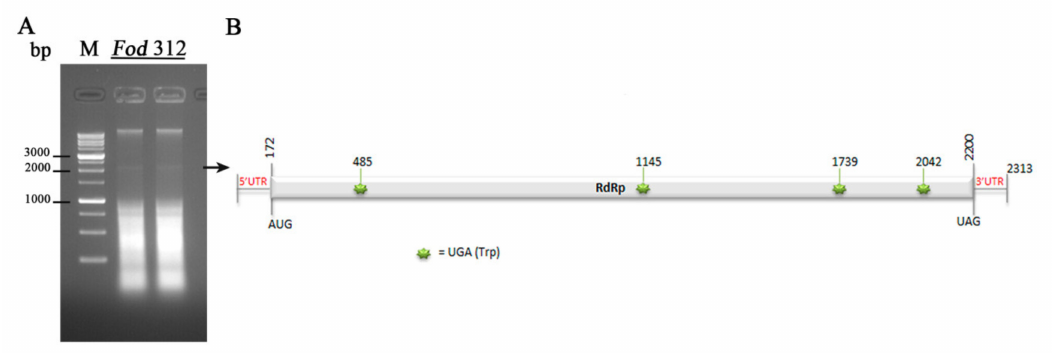
Figure 2. Detection of a mitovirus in isolate Fod 312 and schematic representation of its genomic organization. ( A ) Agarose gel electrophoresis of the dsRNA-enriched extract obtained by cellulose column chromatography from isolate Fod 312 of Fusarium oxysporum f. sp. dianthi. Lane M: 1 kb molecular weight marker (Nippon Genetics, Japan). ( B ) Schematic representation of the genomic organization of Fusarium oxysporum f. sp. dianthi mitovirus 1 (FodMV1). The genome is 2313 bp long and contains a unique ORF that encodes an RNA dependent RNA polymerase (RdRp).